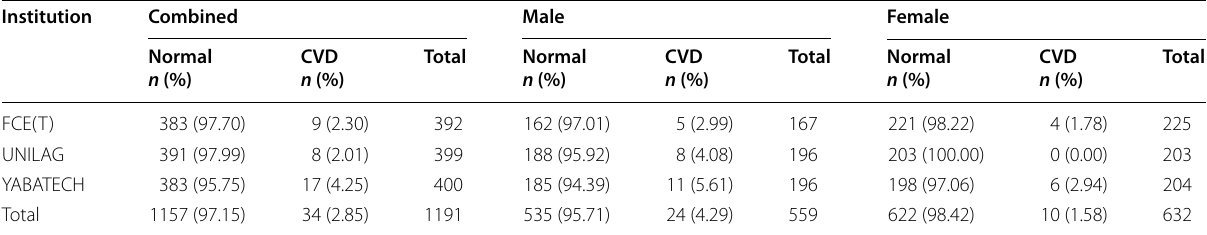
Table 2 Prevalence of colour vision deficiency among male and female students of FCE(T), UNILAG and YABATECH Institution